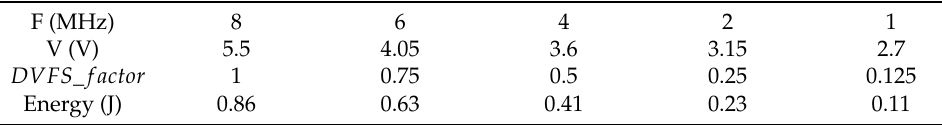
Table 5. Frequency/Voltage Couples Supported by